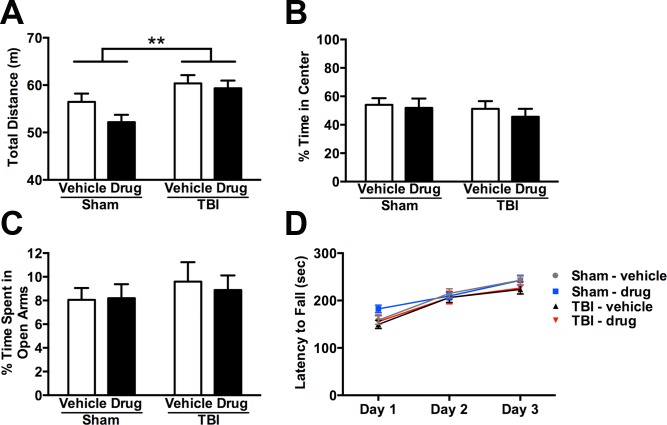
Early gelatinase inhibition does not impact injury-induced hyperactivity, measures of anxiety, or motor function at adulthood after pediatric TBI.(A) Injury resulted in hyperactivity by adulthood, indicated by increased total distance traveled in an open field (2-way ANOVA, effect of injury, **p<0.01). (B) The percent time spent in center of the open field, a measure of anxiety, was not altered by either injury or treatment (2-way ANOVA n.s.). (C) Anxiety was also measured by percent time spent in the open arms of the elevated plus maze, and neither injury nor p-OH SB-3CT treatment affected this measure (2-way ANOVA n.s.). (D) Motor function, evaluated by latency to fall from an accelerating rotarod, was similar in all groups across consecutive testing days (2-way RM ANOVA). Bars represent mean + sem and values represent mean ± sem (n = 15/group).